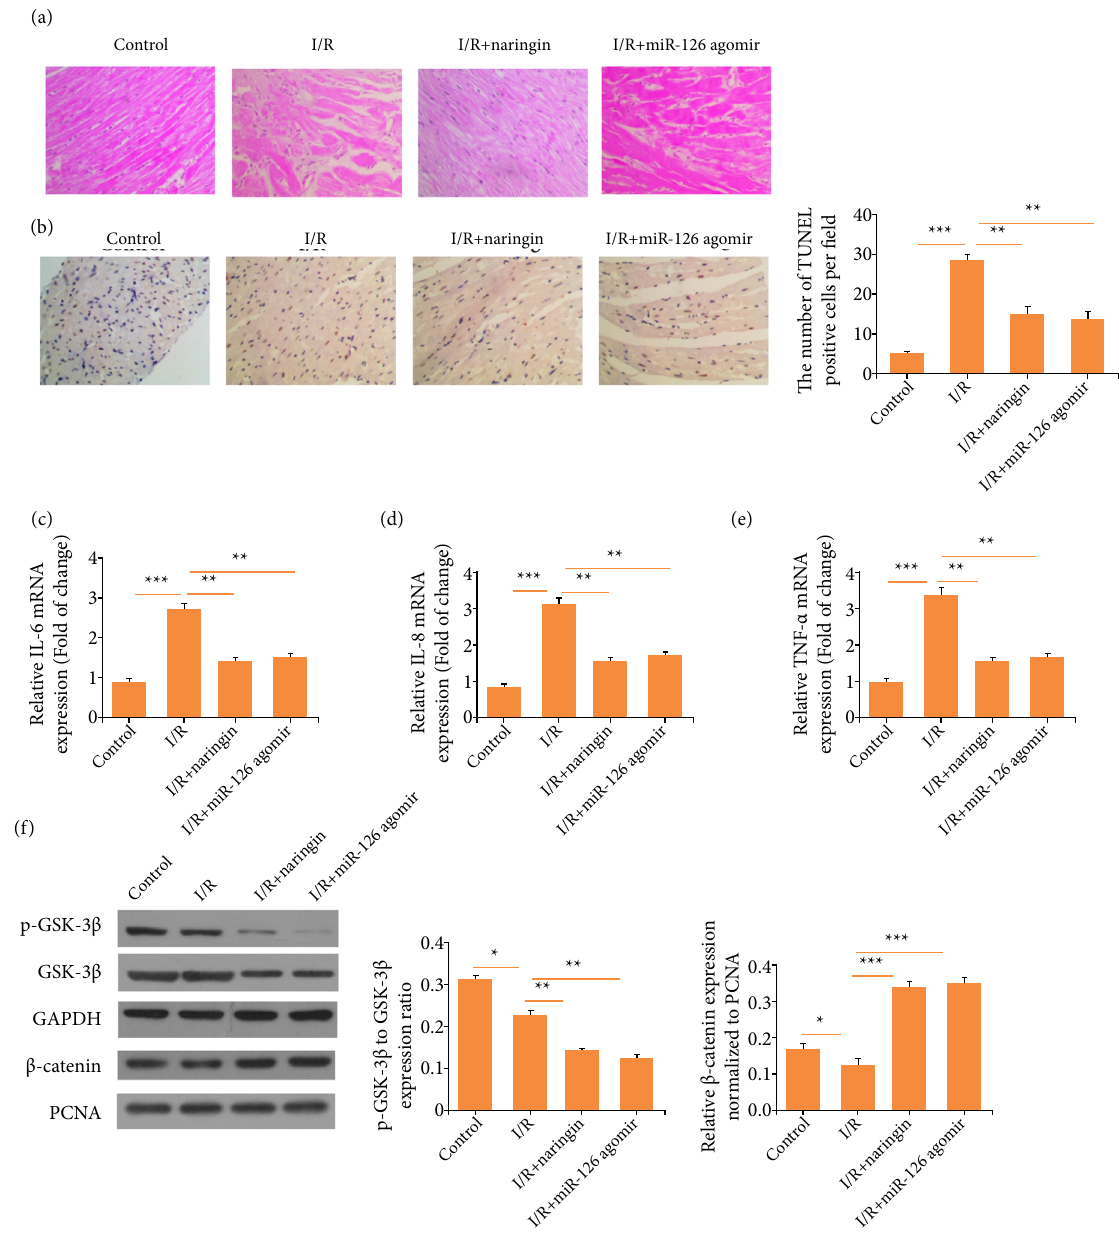
Figure 5 - Naringin ameliorates myocardial ischemia-reperfusion (I/R)-induced damage via miR-126/GSK-3 β signaling pathway. (a) Hematoxylin-eosin (HE) staining for rat’s hearts. (b) TUNEL staining for rat’s hearts. (c) IL-6 concentration. (d) IL-8 concentration. (e) TNF- α concentration. (f) Western blots for GSK-3 β / β -catenin signaling